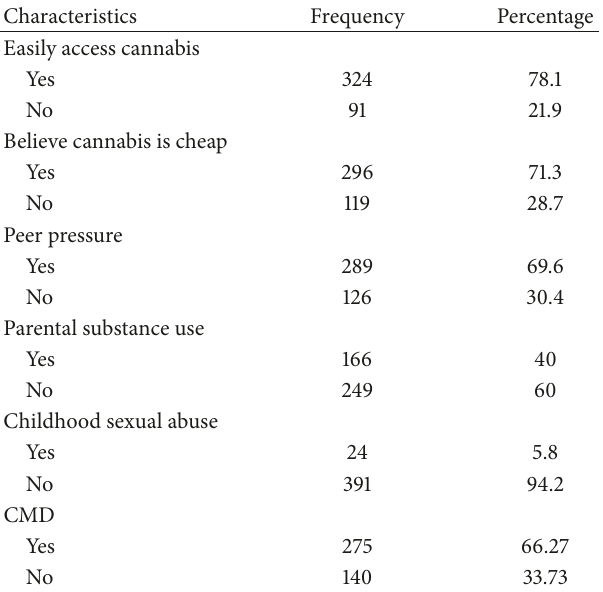
Table 3: Psychosocial and clinical factors of respondents at Shashemene Town, Oromia Region, Ethiopia,